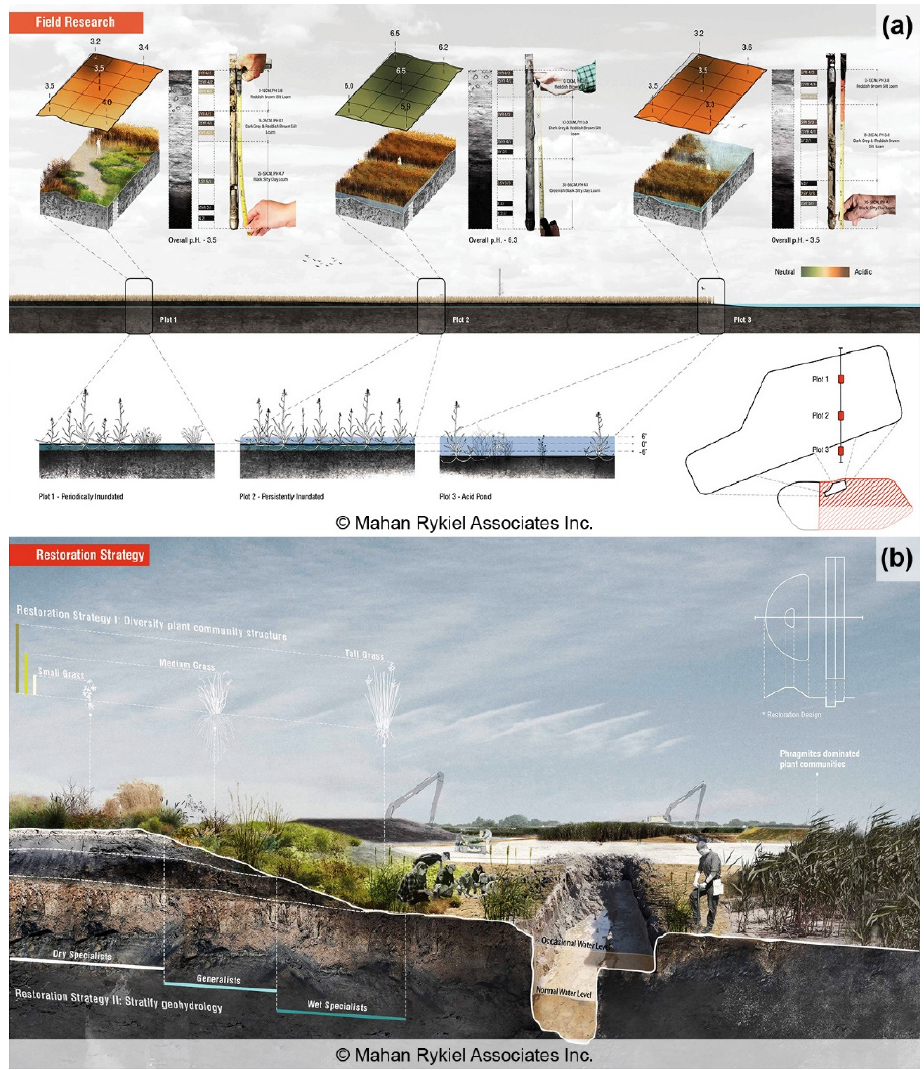
Figure 3. Project working images and diagrams regarding ( a ) field research and ( b ) restoration strategy. Reprinted with permission from ref. [73]. Copyright 2021 Mahan Rykiel Associates Inc.